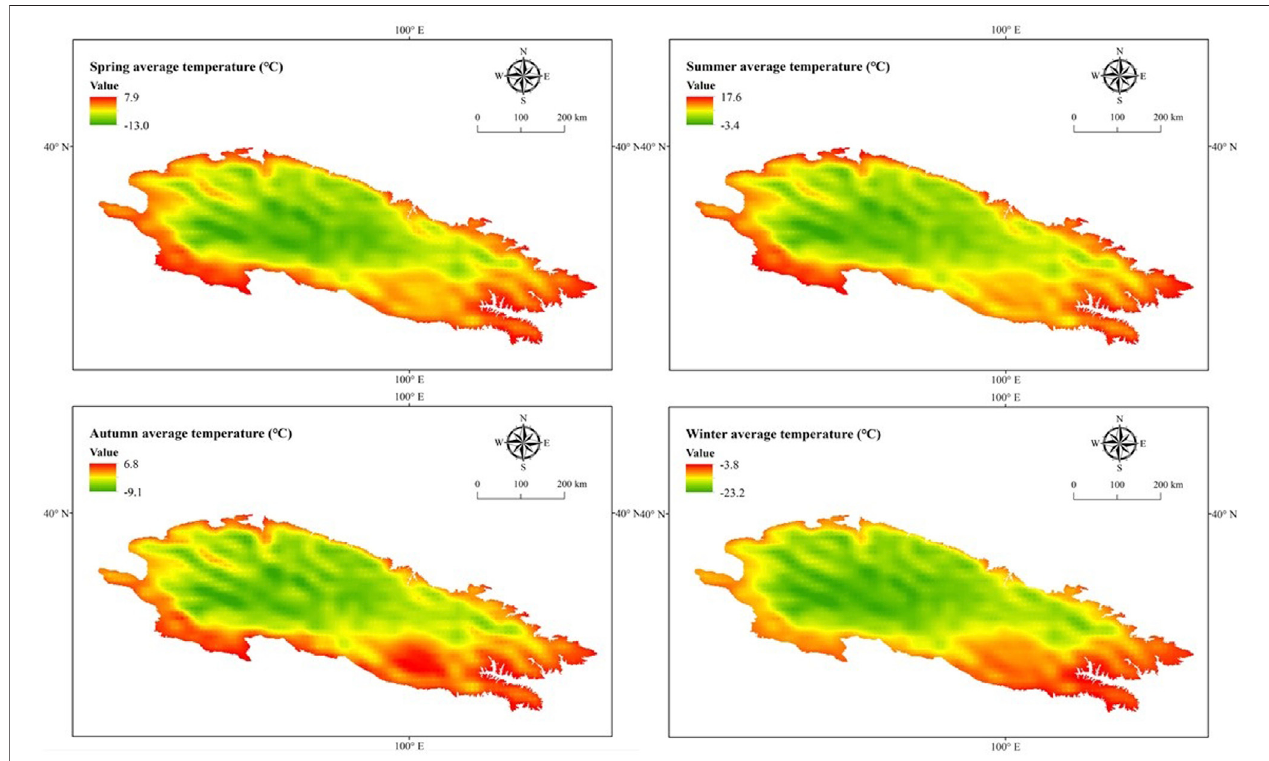
FIGURE 3 | Spatial distribution of seasonal mean ERA5-Land temperature in the QLM.